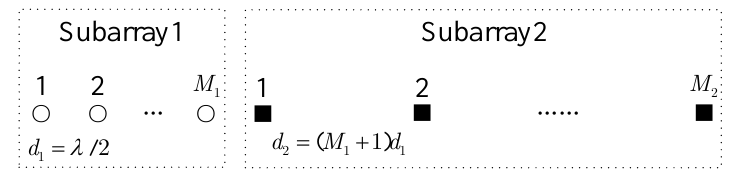
Figure 1. A two-level nested array geometry.